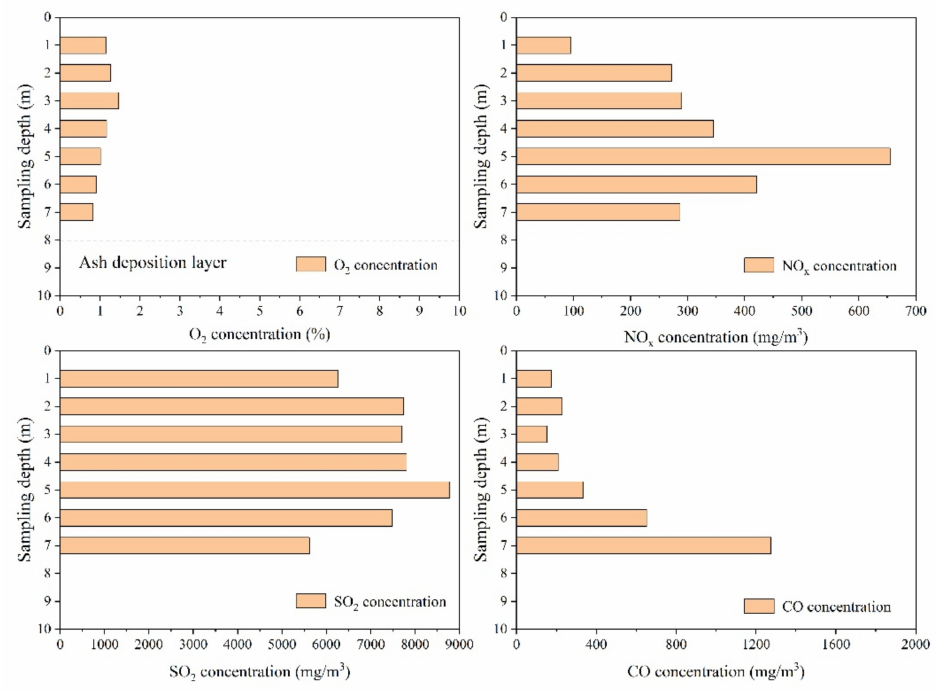
Figure 9. Vertical distributions of flue gas composition at the #C SNCR